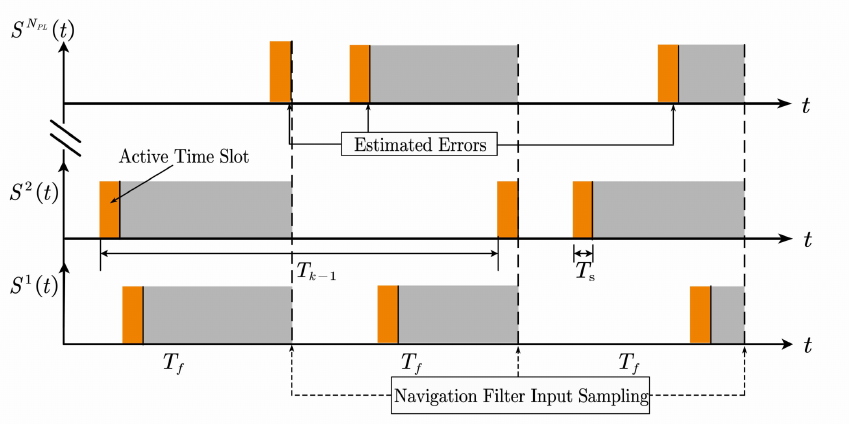
Figure 4. Schematic diagram of input sampling for navigation filter.